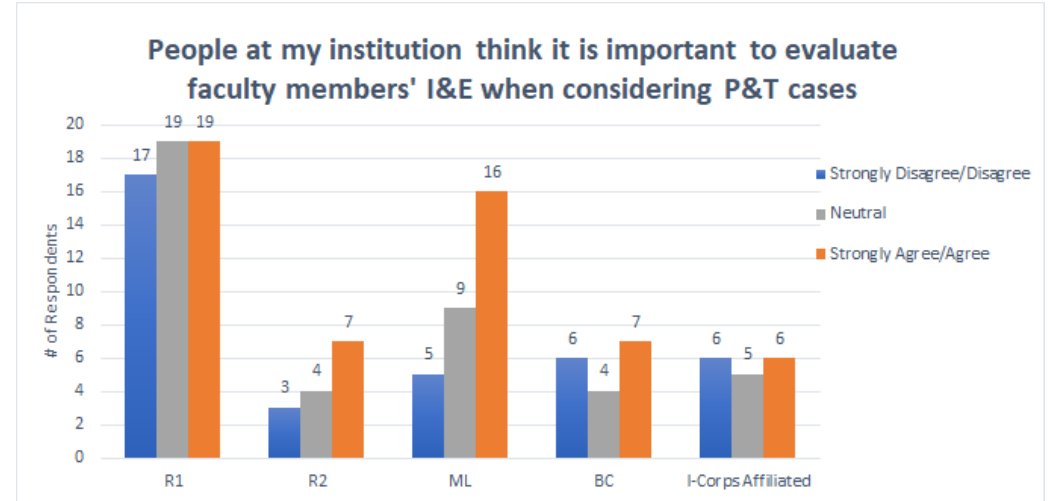
Figure 3. Comparison of respondents’ perceptions of how other people at their institution regard the importance of evaluating faculty members’ I&E when considering faculty P&T cases at their institutions.